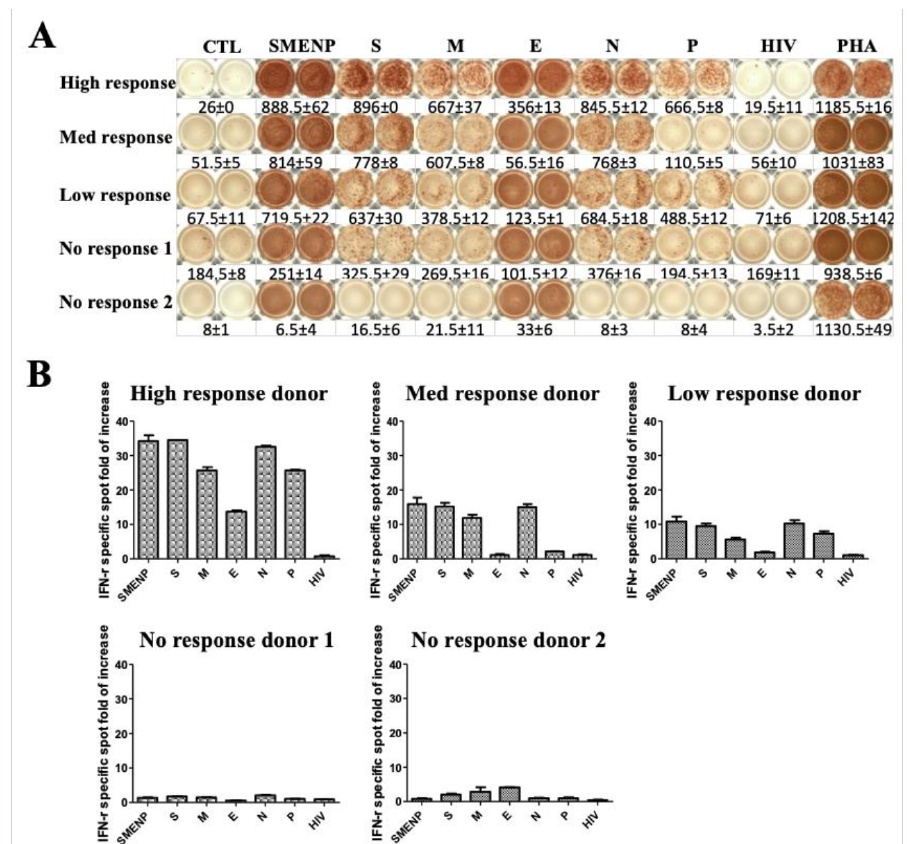
Figure 3. Primary activated T cells for 12 days against SARS-CoV-2 antigens. ( A ) IFN- γ ELISPOT assay of T cells from selected responders. T cells were cultured for 12 days from the different subjects including no, low, medium, and high responders. PHA treatment served as positive control, and HIV-1 peptides and CTL without antigen served as background controls. ( B ) Bar graph analysis of the IFN- γ specific T-cell expansion fold of increase based on spot-forming cells against the different viral antigens for the five subjects. The error bars depict the variation range of the